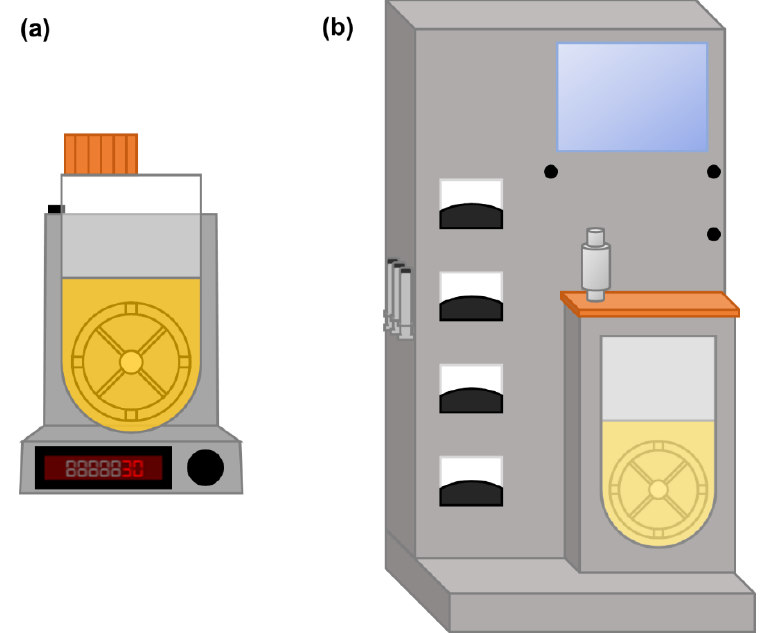
Figure 8. Schematics of a Vertical-Wheel bioreactor: ( a ) 100 mL vessel with base and ( b ) 3 L vessel with an embedded controller.